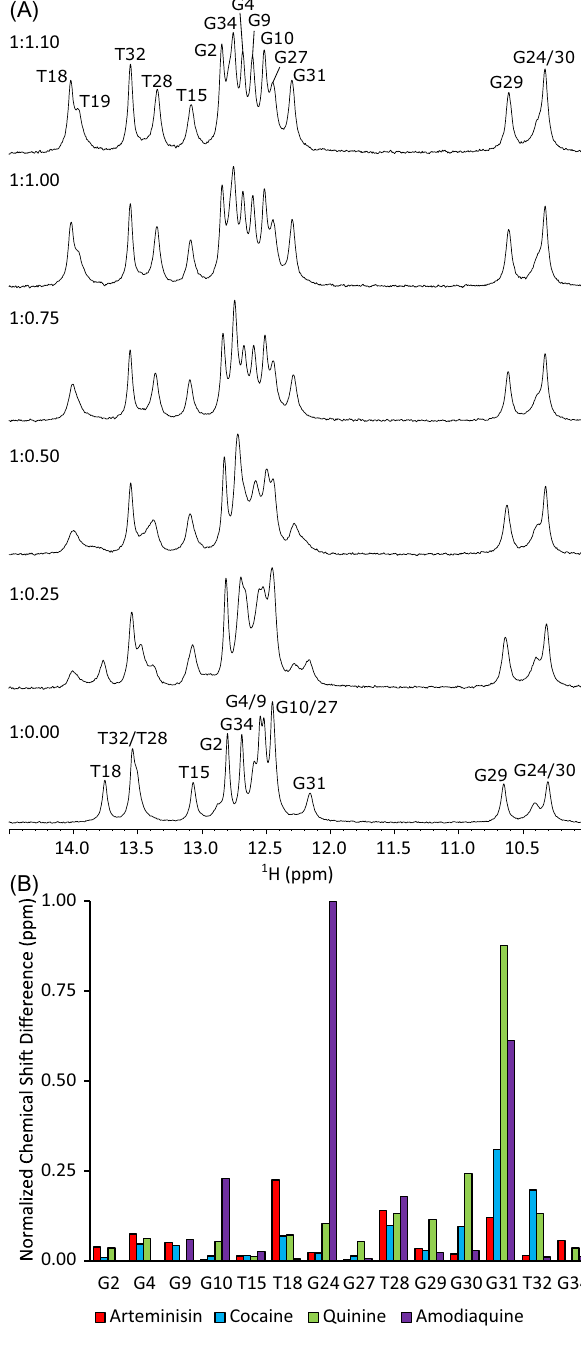
Figure 4. ( A ) 1 H NMR spectra showing the imino proton resonances of MN4 as ART is titrated into the sample up to a 1:1.1 molar ratio of aptamer to ligand. Sample contained 1.4 mM aptamer, 20 mM H x Na y PO 4 , pH 7.4, 10% D 2 O. Final titration point contains ~ 3% DMSO-d 6 . Spectra acquired at 5 °C. ( B ) Histograms showing the absolute value of the difference in peak position of the imino protons for free and ligand-bound MN4. Data is normalized to the largest chemical shift difference value. Displayed ligands are ART (red), quinine (green), cocaine (blue) and amodiaquine (purple). The cocaine, amodiaquine and quinine change in chemical shift data are based on previous published data 9,14